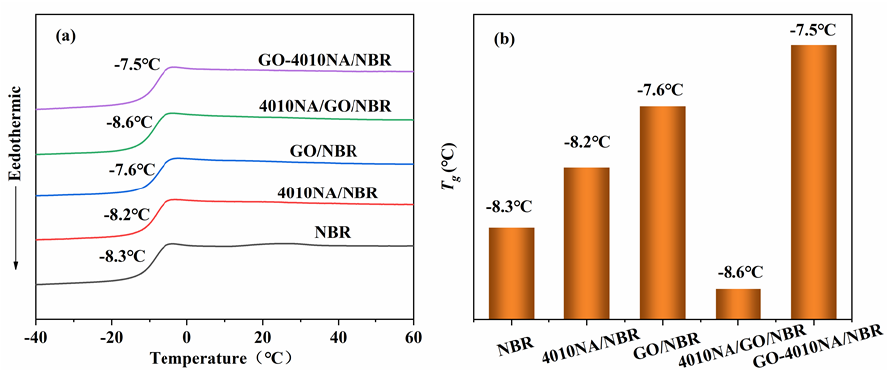
Figure 7. ( a ) DSC curves of different NBR composites and ( b ) the Tg of different NBR